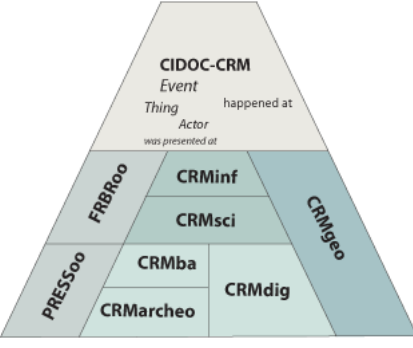
Figure 2. CIDOC CRM-core with